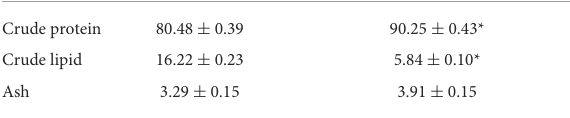
TABLE 3 Proximate composition of the squid by-products and the hydrolysate (% dry